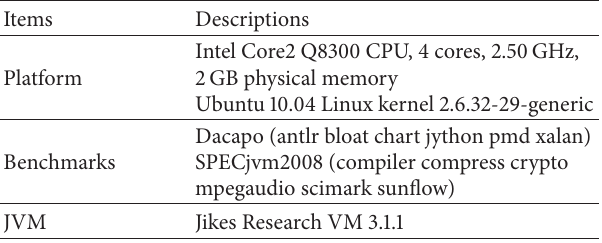
Table 1: Measurements setup details.